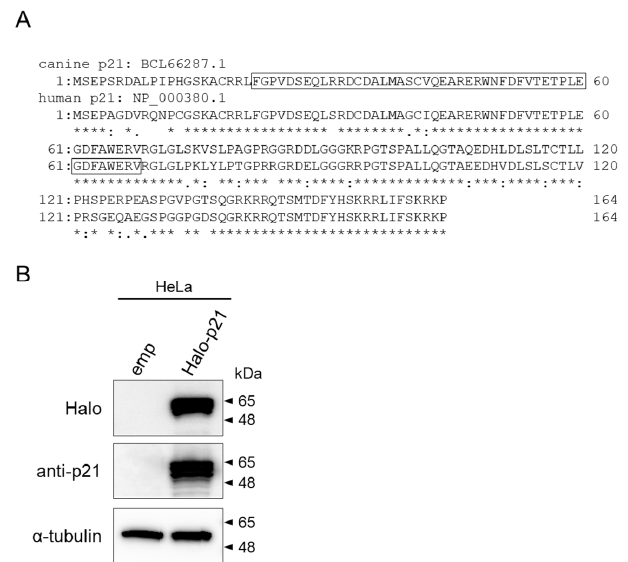
Figure 6. Structure analysis of canine p21 and cross-reactivity of anti-p21 antibody. ( A ) The amino acid sequence of canine p21 (BCL66287.1) was aligned with that of the human p21 (NP_000380.1) using ClustalW. Residues are denoted as full conservation (*), conservation of the strong amino group (:), or conservation of the weak amino group ( · ). The conserved functional domain of cyclin-dependent kinase inhibitor predicted using InterPro is boxed. ( B ) Western blot analysis using anti-Halo or human p21 antibodies. Cell lysates from Halo-tagged p21 forced expressed HeLa cells were electrophoresed using 5–20% gels. α -tubulin was used as a reference protein for the normalization of protein loading. (The original gel figures can be found in the Supplementary Materials.).